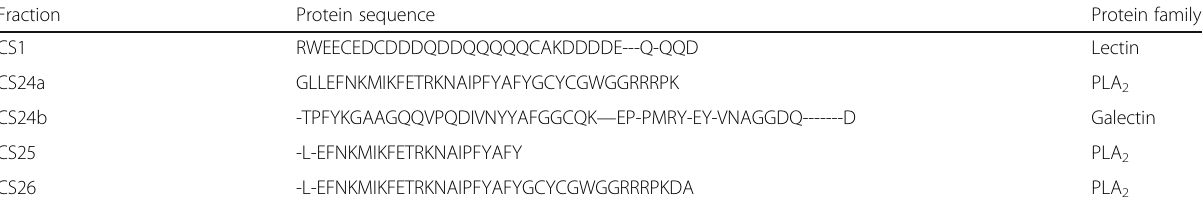
Table 4 N-terminal sequences from the poison fractions by Edman ’ s degradation technique Fraction Protein sequence Protein